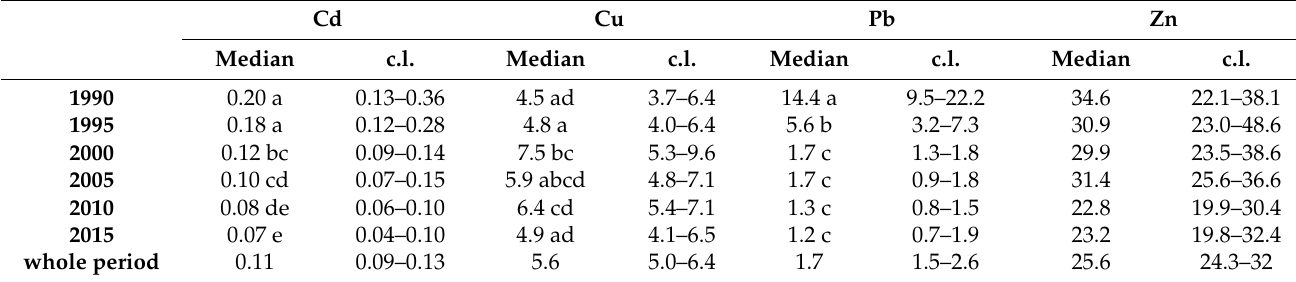
Table 1. Median and 95% confidence limits (c.l.) of Cd, Cu, Pb, and Zn concentrations ( µ g g − 1 dw) in moss at background sites of Switzerland. Different letters in a column indicate statistically significant ( p < 0.05) differences. Cd Cu Pb Zn Median c.l. Median